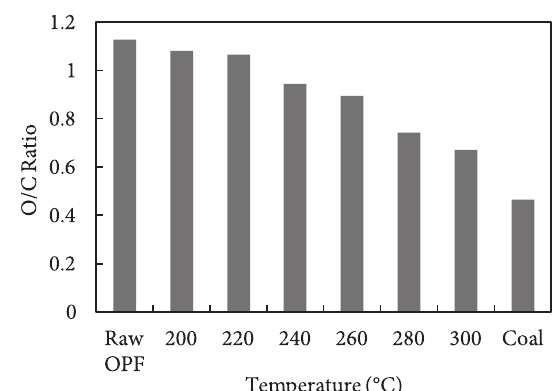
Figure 5. Effect of temperature on O/C